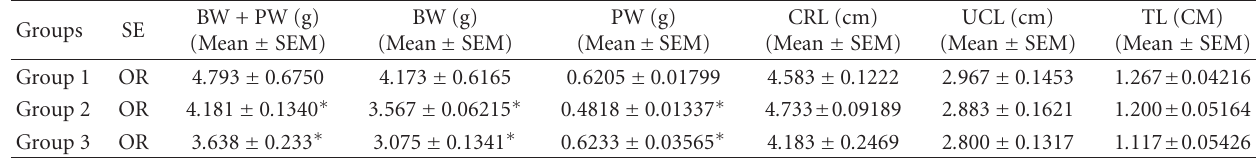
Table 2: Incidence of growth retardation and size abnormality in fetuses of treated